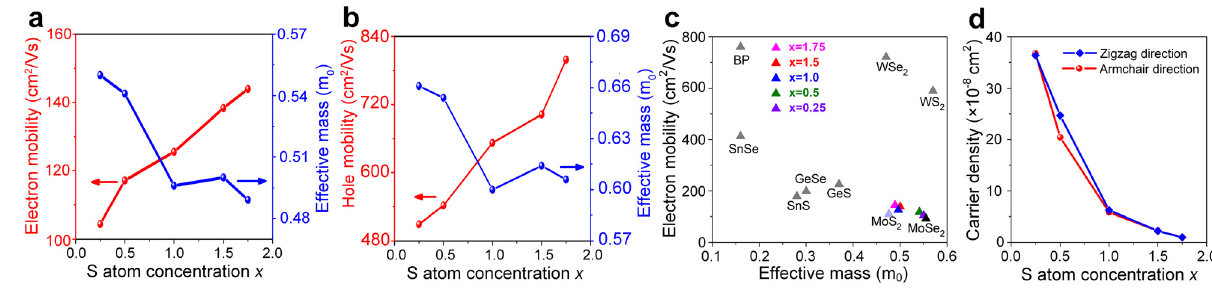
Figure 1: The calculated carrier parameters of MoS x Se 2 − x . (a)ElectronmobilityandeffectivemassasafunctionofSconcentration x .(b)HolemobilityandeffectivemassasafunctionofSconcentration x . (c) Summary of the electron mobility and effective mass of 2D TMDCs semiconductors [46, 47]. (d) Carrier concentration along the armchair and zigzag directions as a function of S concentration x